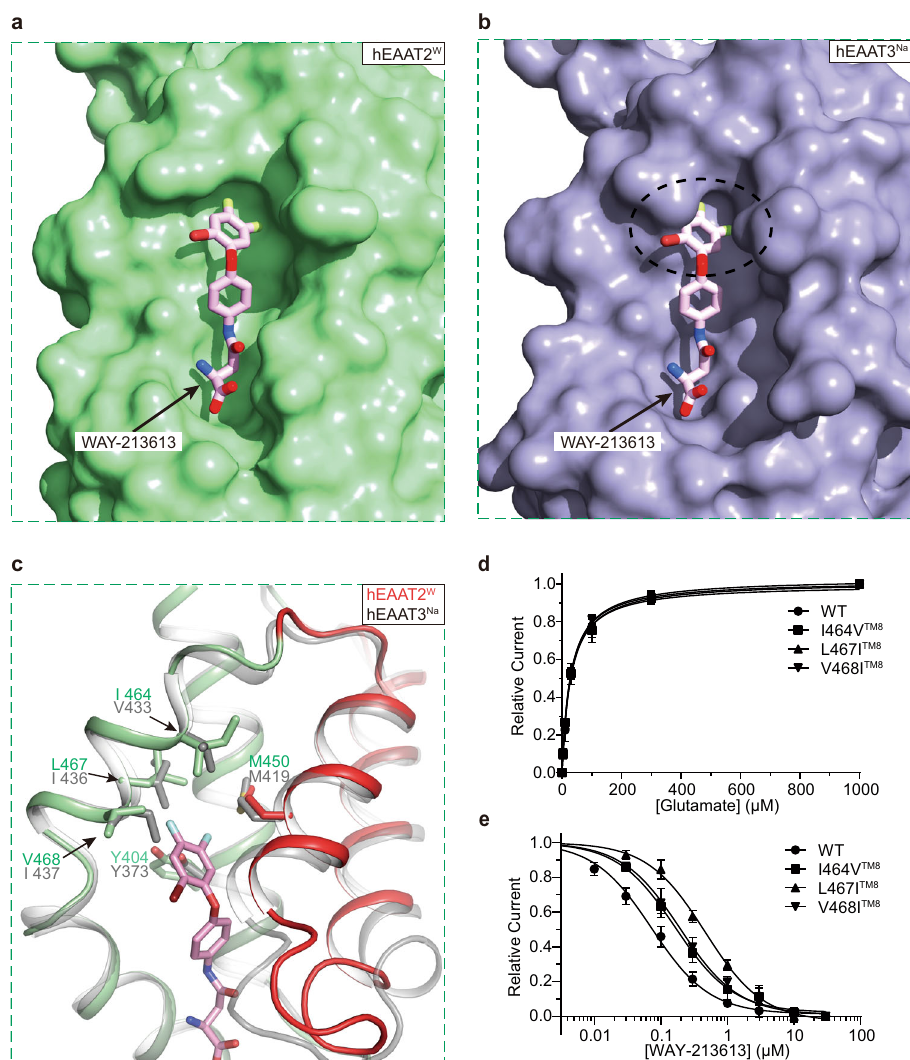
Fig. 4 Structural basis for the selectivity of WAY-213613. a Surface representation of the WAY-213613 pocket in the hEAAT2 W (pale green). The WAY- 213613 is displayed in sticks (pink). b Docking of WAY-213613 into the hEAAT3 Na (PDB ID: 6X2L). The surface representation of hEAAT3 Na (blue) indicates a shrinkage of the WAY-213613 binding pocket in hEAAT3. The WAY-213613 is displayed in sticks (pink). c Structural comparison of the transport domain of hEAAT2 W (pale green) and hEAAT3 Na (PDB ID: 6X2L, gray). WAY-213613 and hydrophobic residues in its binding pocket are displayed in sticks. The HP2 of hEAAT2 W is colored in red. d Glutamate dose-response relationships for the I464V TM8 , L467I TM8 , or V468I TM8 mediated currents. The dose-response relationships for the tested mutants were analyzed at the varied concentrations of glutamate indicated in Fig. 1a. Sample sizes ( n ) tested from low to high concentrations are listed as follows: n = 5, 5, 5, 5, 5, and 5 cells for the mutant I464V TM8 ; n = 4, 4, 5, 5, 5, and 5 cells for the mutant L467I TM8 ; n = 5, 5, 5, 5, 4, and 6 cells for the mutant V468I TM8 . e WAY-213613 dose-response relationships for the I464V TM8 , L467I TM8, or V468I TM8 mediated currents. The dose-response relationships for the hEAAT2 mutants as WAY-213613 were varied at the indicated concentrations in Fig. 1b. The lines represent the best fi ts to a Michaelis-Menten-like equation with apparent K i of 0.166 μ M, 0.464 μ M, and 0.196 μ M, respectively. Currents were normalized to the maximal current recorded after application of 30 μ M WAY-213613. Sample sizes ( n ) tested from low to high concentrations are: n = 5, 5, 5, 4, 4, 5, and 10 cells for I464V TM8 ; n = 5, 5, 5, 5, 5, 4, and 11 cells for L467I TM8 ; n = 5, 5, 5, 5, 5, 5, and 11 cells for V468I TM8 . The data of wild- type hEAAT2 from Fig. 1b was compared with those of the tested mutants. In fi gs. d and e , all experiments were executed at 0 mV and data were presented as mean values ±